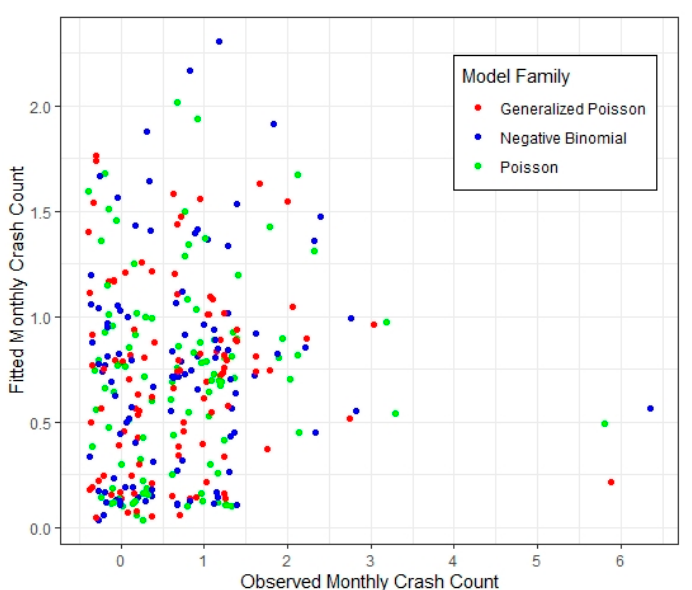
Figure 2. Intersection fitted crash counts versus observed crash counts.